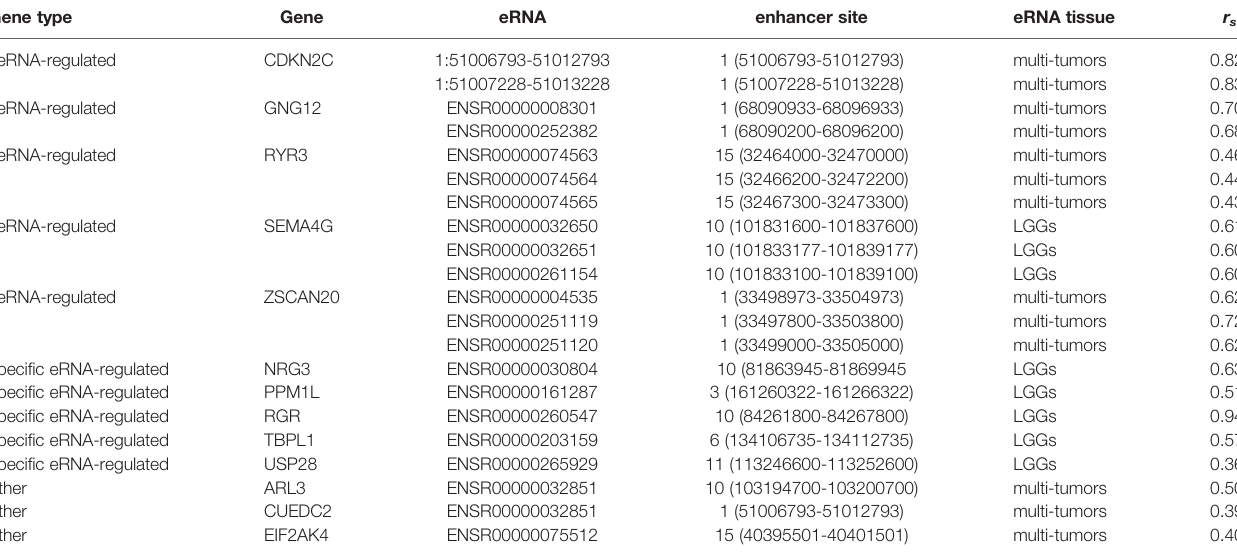
TABLE 1 | The relationship between eRNA and